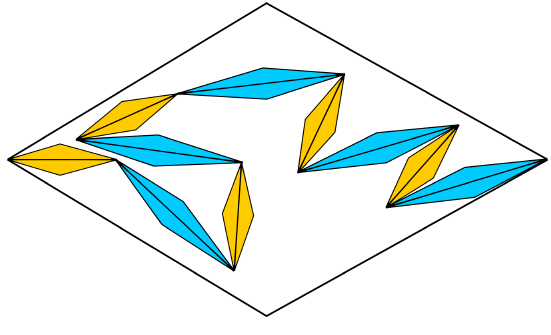
Figure 3: Generators of an IFS for a self-affine snowflake